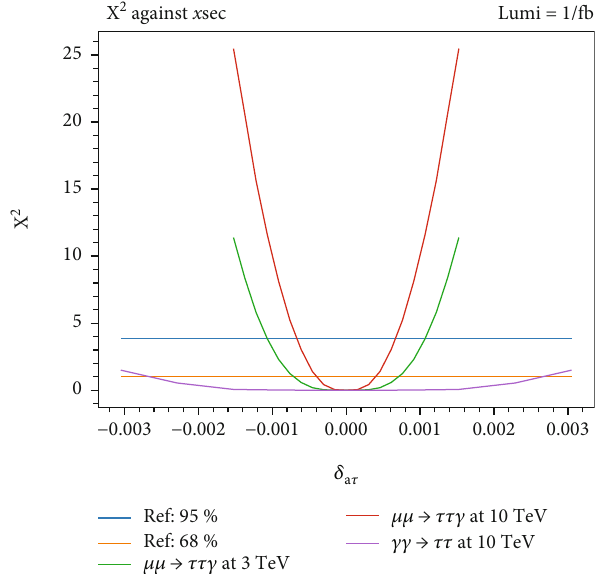
Figure 3: Projected sensitivity on tau g − 2 for both μμ ⟶ ττγ and γγ ⟶ ττ processes, at a 3 or 10 TeV muon collider with 1 fb − 1 and perfect event e ffi ciency is